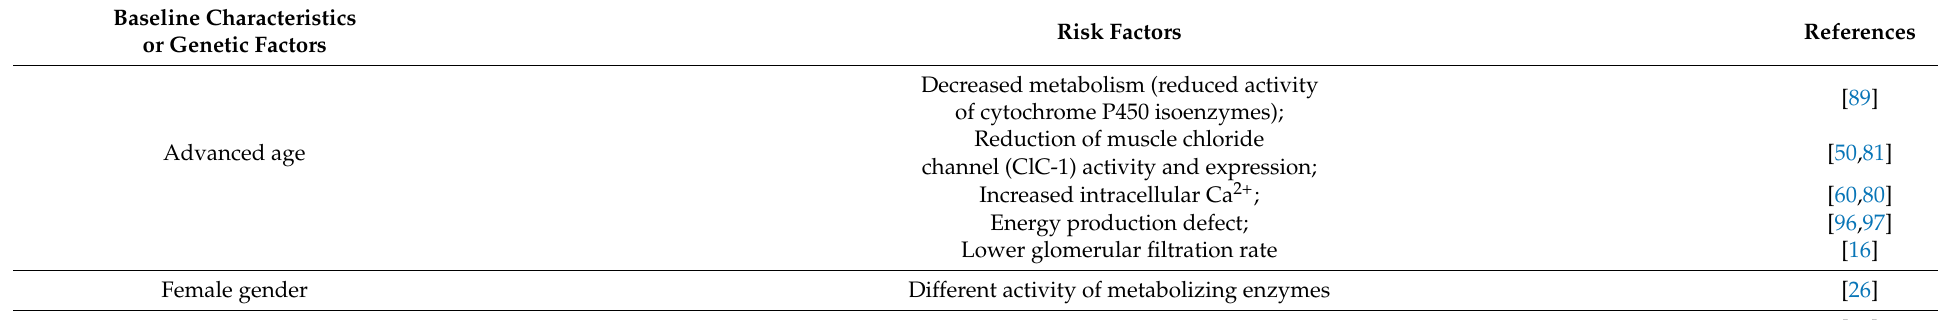
Table 1. Risk factors that may increase statin-induced muscle